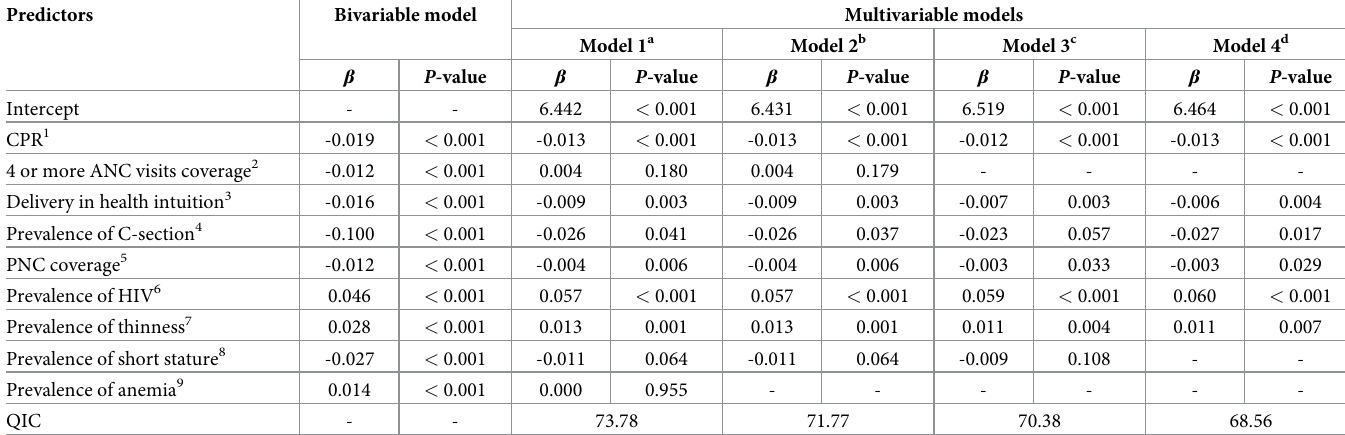
Table 3. Summary of the predictors of